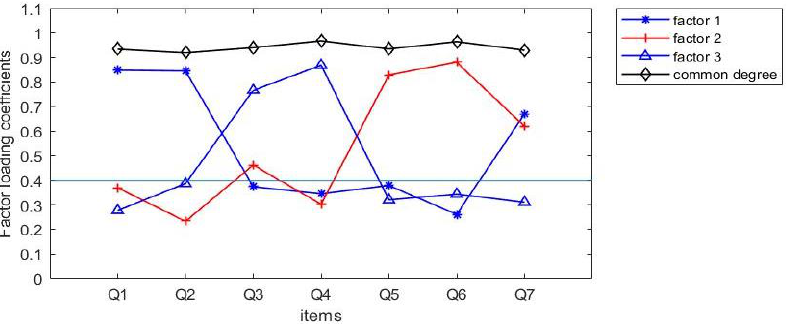
Figure 4. Factor loading metrics (rotated).